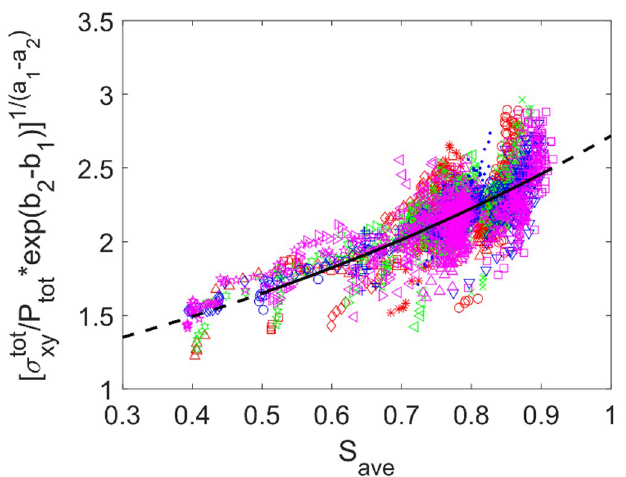
Figure 18. Collapse of the ratios of shear stress to pressure for binary mixtures ( AR = 0.15 and AR = 6) with various rods fractions C and solid volume fractions ν . The legend of symbols in Figure 17a is also applied in this figure.